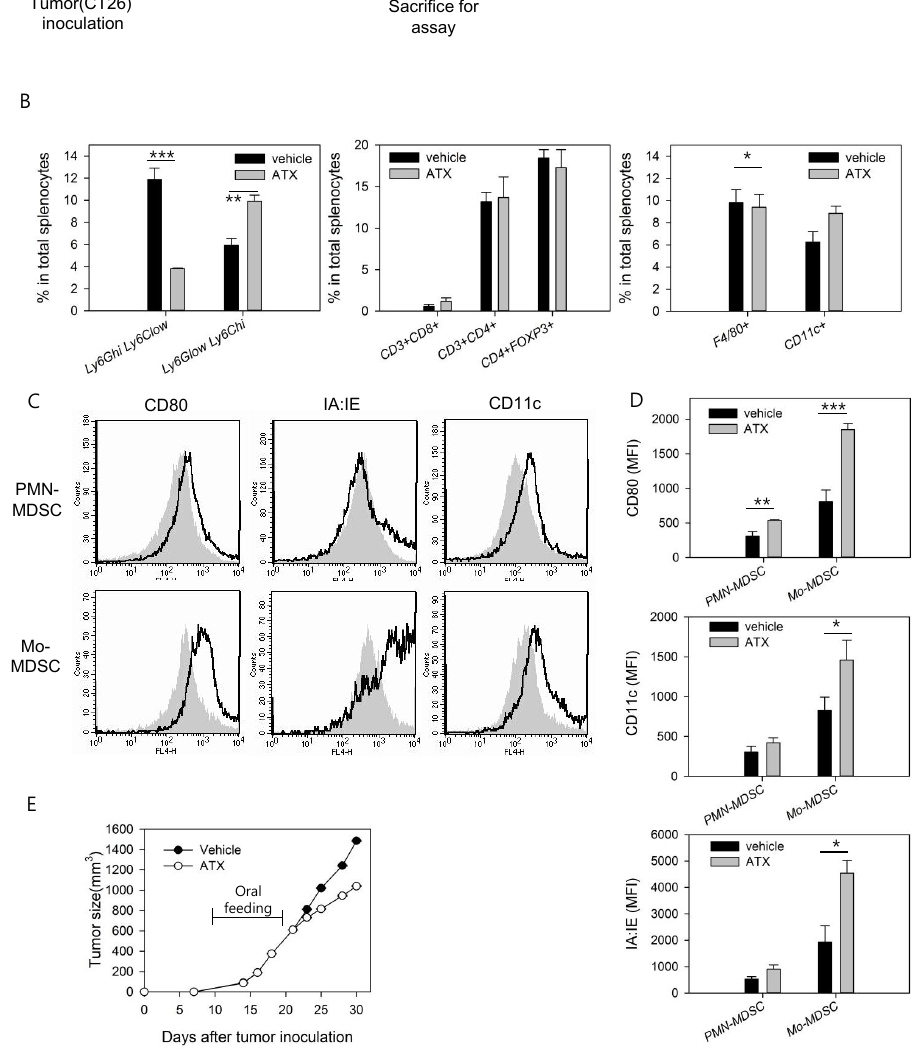
Figure 1. Changes in the percentages and phenotype of myeloid-derived suppressor cells (MDSCs) are induced in tumor-bearing mice treated with astaxanthin (ATX). Tumor-bearing mice were treated orally with ATX (50 mg / kg) daily for 10 days (n = 4 / group). After treatment, mice were sacrificed and their splenocytes were stained with fluorescent-labeled Abs. For analysis of MDSCs, CD11b + cells were separated from splenocytes, then stained with fluorescent-labeled Abs. Splenocytes were analyzed by flow cytometry. ( A ) Experimental schedule for ATX treatment of tumor-bearing mice. ( B ) Percentages of Ly-6G high Ly-6C low polymorphonuclear (PMN)-MDSCs and Ly-6G low Ly-6C high mononuclear (Mo)-MDSCs (left). Percentages of CD8 + T cells, CD4 + T cells, and FoxP3 + regulatory T (Treg) cells (middle). Percentages of F4 / 80 + cells and CD11c + cells (right). ( C ) Surface markers on PMN-MDSCs and Mo-MDSCs. Histograms show data of veh-treated mice as filled areas and ATX-treated mice as bold lines. ( D ) Mean fluorescence intensities (MFIs) of MDSCs are shown as means ± SEM (n = 3). ( E ) Tumor size was monitored at 2-3 day intervals. Representative data from two independent experiments. * p < 0.05, ** p < 0.01, *** p <